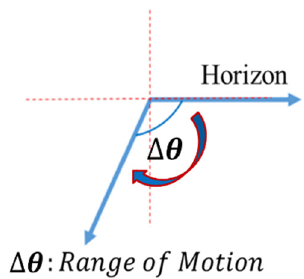
Figure 1. Range of motion (ROM).